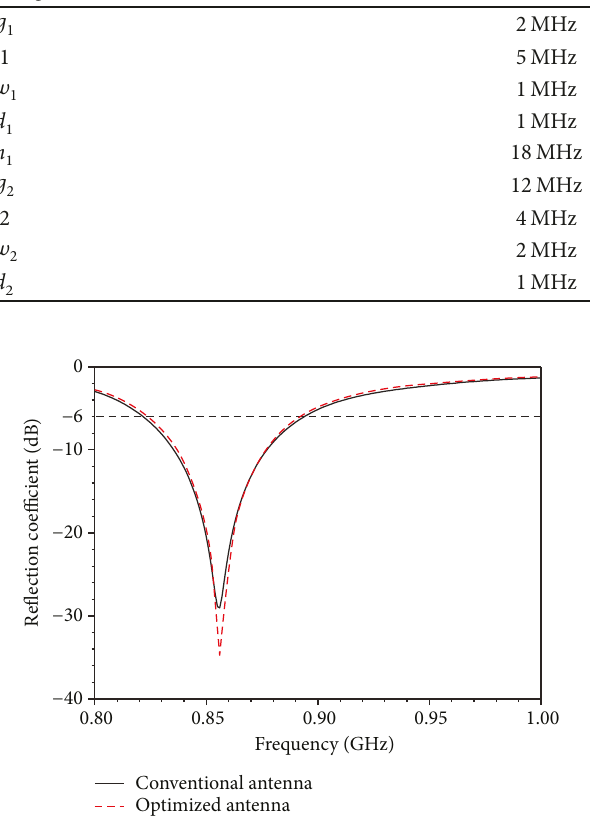
Figure 4: Simulated resonant frequencies of the conventional antenna according to the changes in (a) g , (h) d , and (i) h . (g) d 1 2 1 Table 2: Variance of the resonant frequency of each design variable. Design